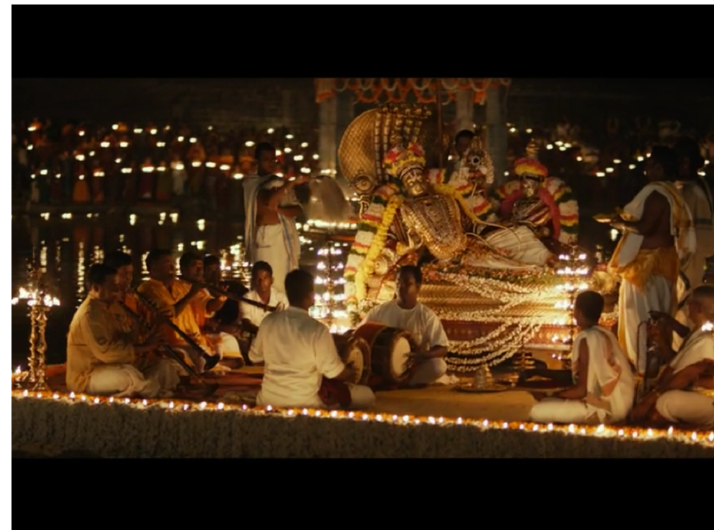
Figure 4. Hindu ritual and filmic ritual intertwine in The Life of Pi .